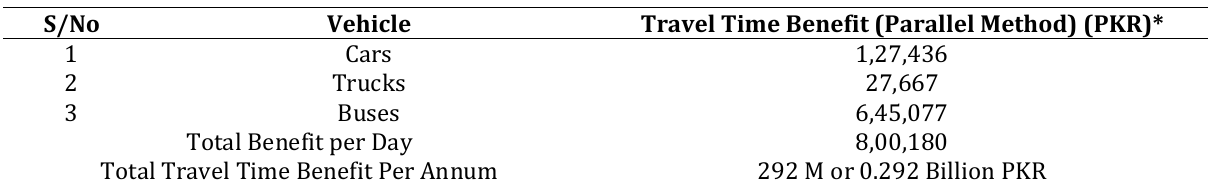
Table 3. Travel Time Benefit